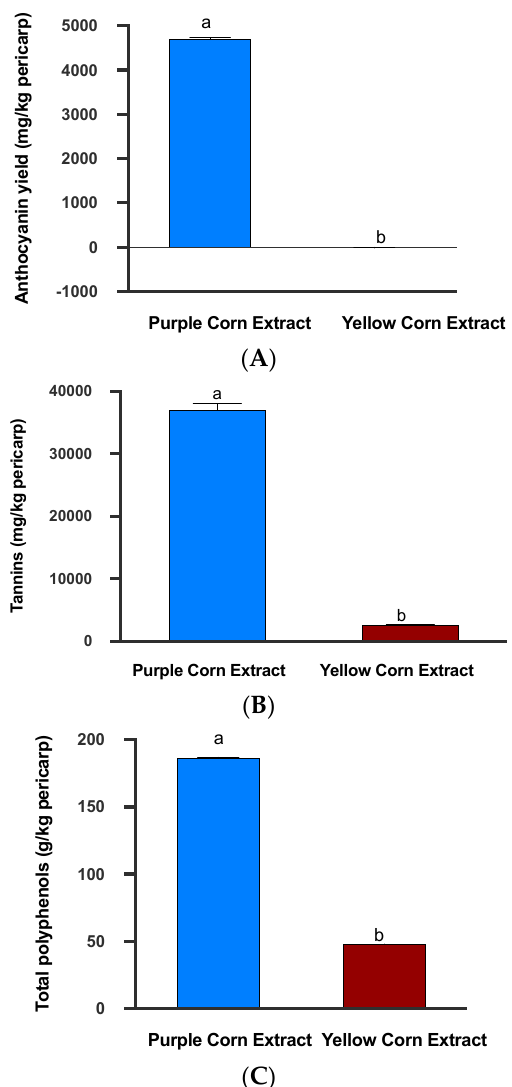
Figure 2. Mean anthocyanins ( A ), tannins ( B ), and total polyphenols ( C ) present in the purple corn and yellow corn pericarp extracts. Means followed by different letters are significantly different (Mann – Whitney U test, unpaired t-test, p < 0.05).